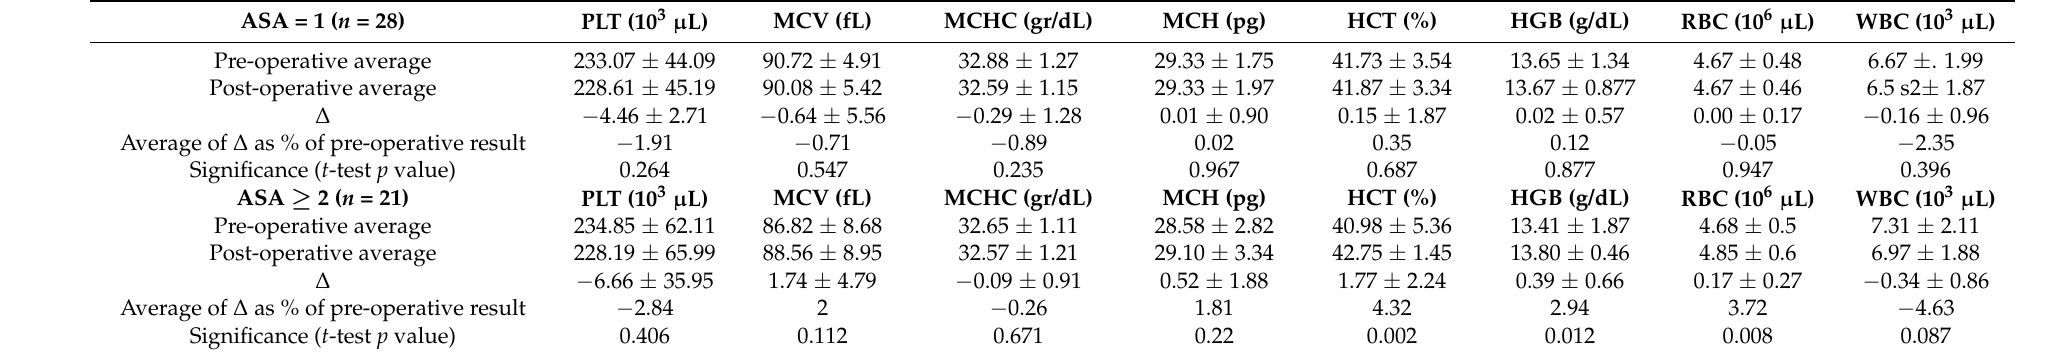
Table 4. Change between pre-operative and post-operative CBC stratified by ASA